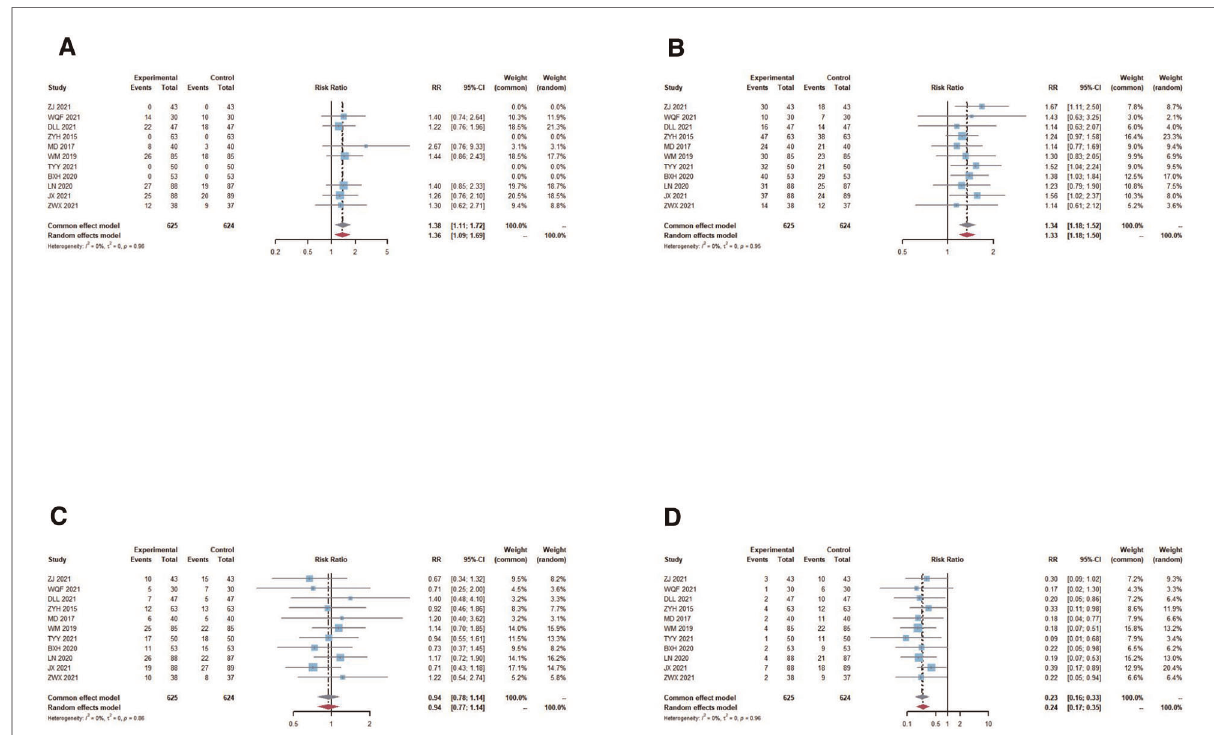
FIGURE 3 Overall meta-analysis forest plot of treatment effect rates. ( A ) cure rate, a fi xed effects model was used as no signi fi cant heterogeneity ( I 2 =0.0%, P = 0.9611) was found. The result (RR=1.3863; 95% CI, 1.1008; 1.7458, P =0.0043) indicated that TCM plus DNG was superior to DNG/TCM alone